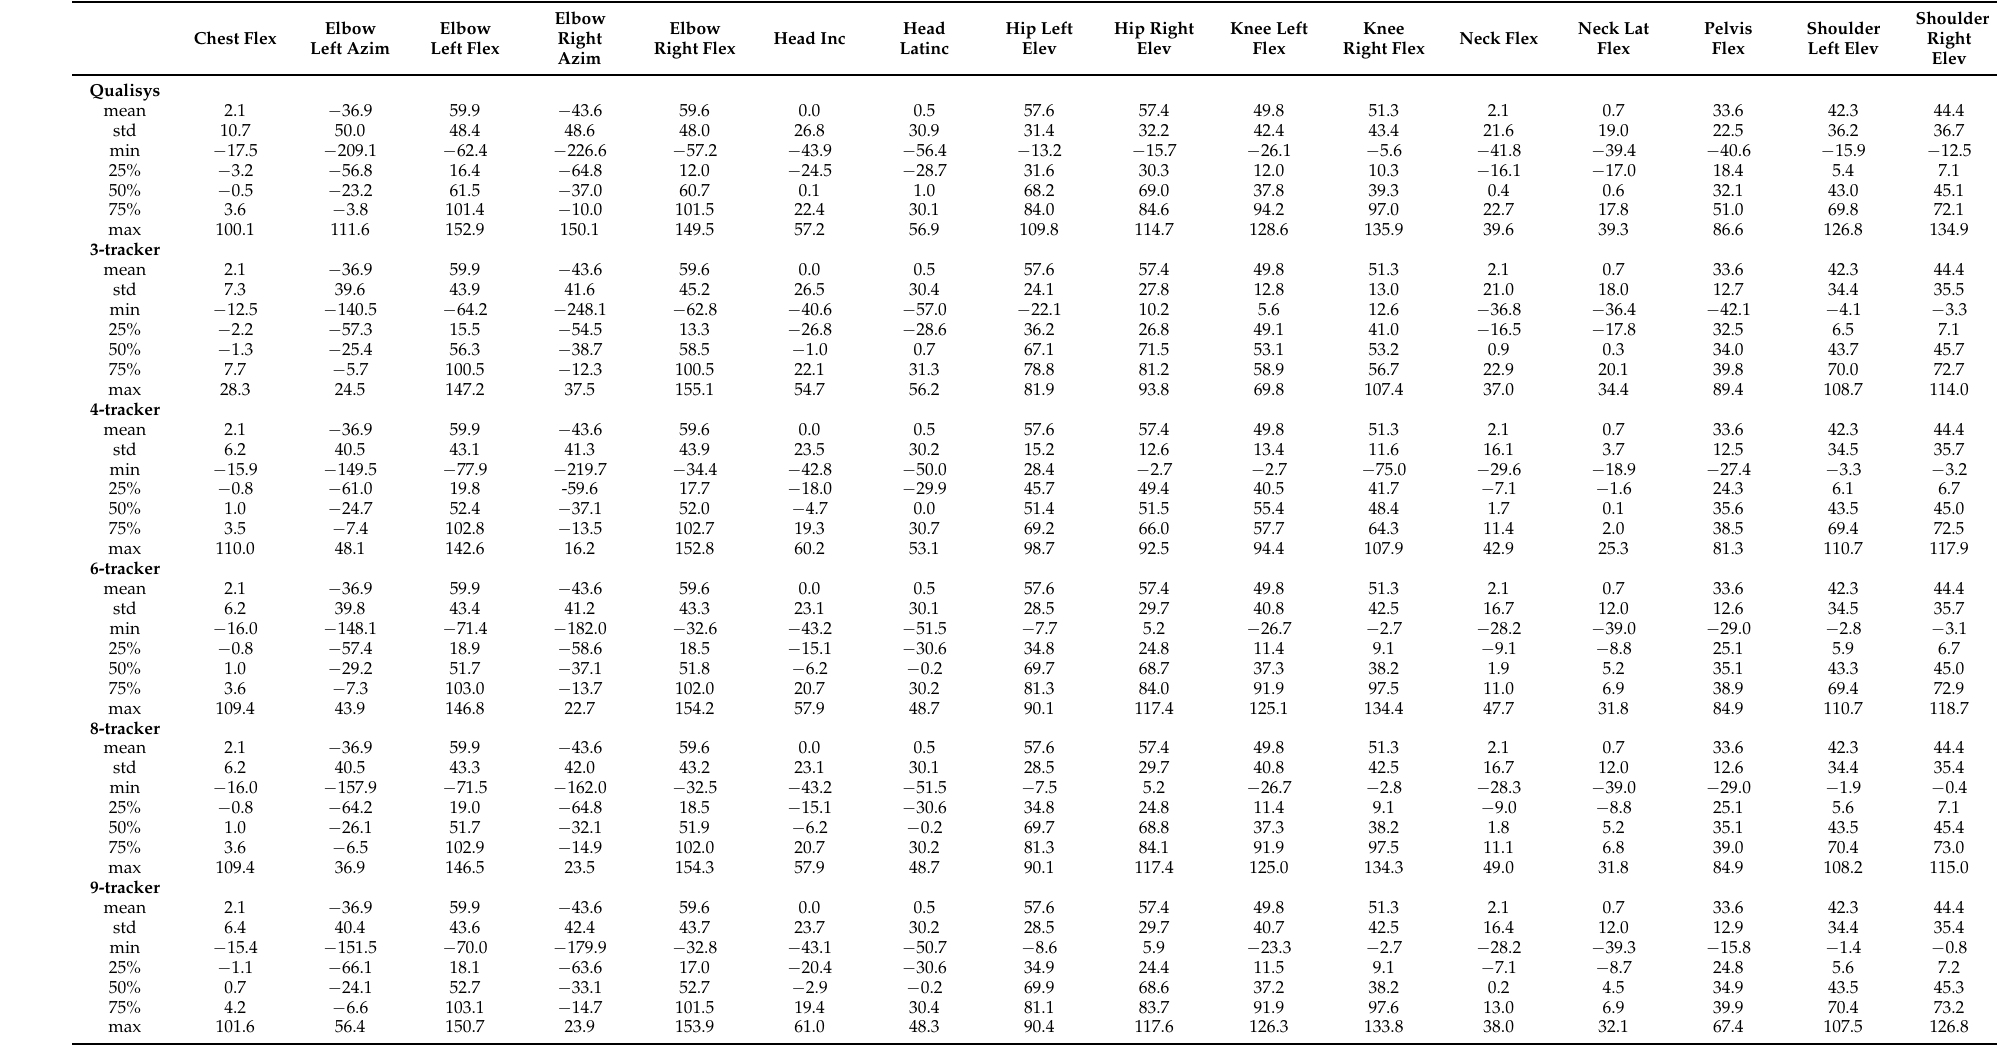
Table A1. Data statistics of the analyzed joint angles; 25%, 50% and 75% quartiles, mean value, standard deviation minimum and maximum [ ◦